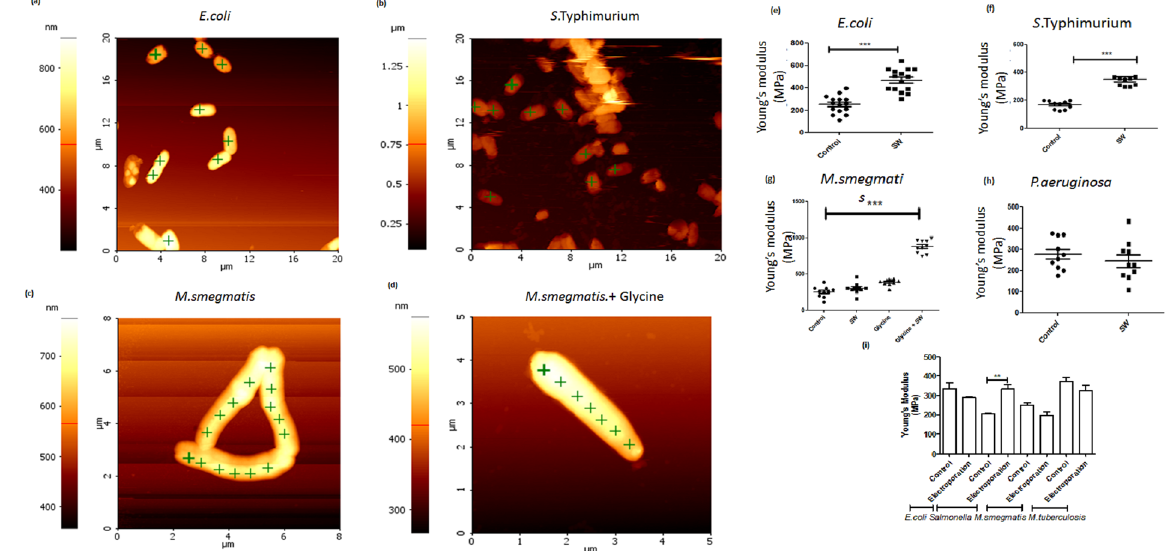
Figure 5. Determination of Young’s modulus of bacteria after shockwave exposure. ( a ) E.coli , ( b ) Salmonella , ( c ) M. smegmatis and ( d ) M. smegmatis grown in presence of 1.5% Glycine were either exposed to shockwaves or were unexposed prior to atomic force microscopy for measuring the Young’s modulus, a measure of elasticity. Uniformly spaced points for indentation were selected on the bacterial surface and contact mode indentation was performed. The force displacement curves were analyzed using the Hertzian model. A total of 10 bacteria were analyzed per sample. The images are representative of the experiment. ( e–h ) Comparison of Young’s modulus after shockwave exposure. ( i ) Comparison of Young’s modulus after electroporation. Statistical significance was defined as follows ( * P < 0.05, ** P < 0.005, *** P < 0.0005) (Student’s t